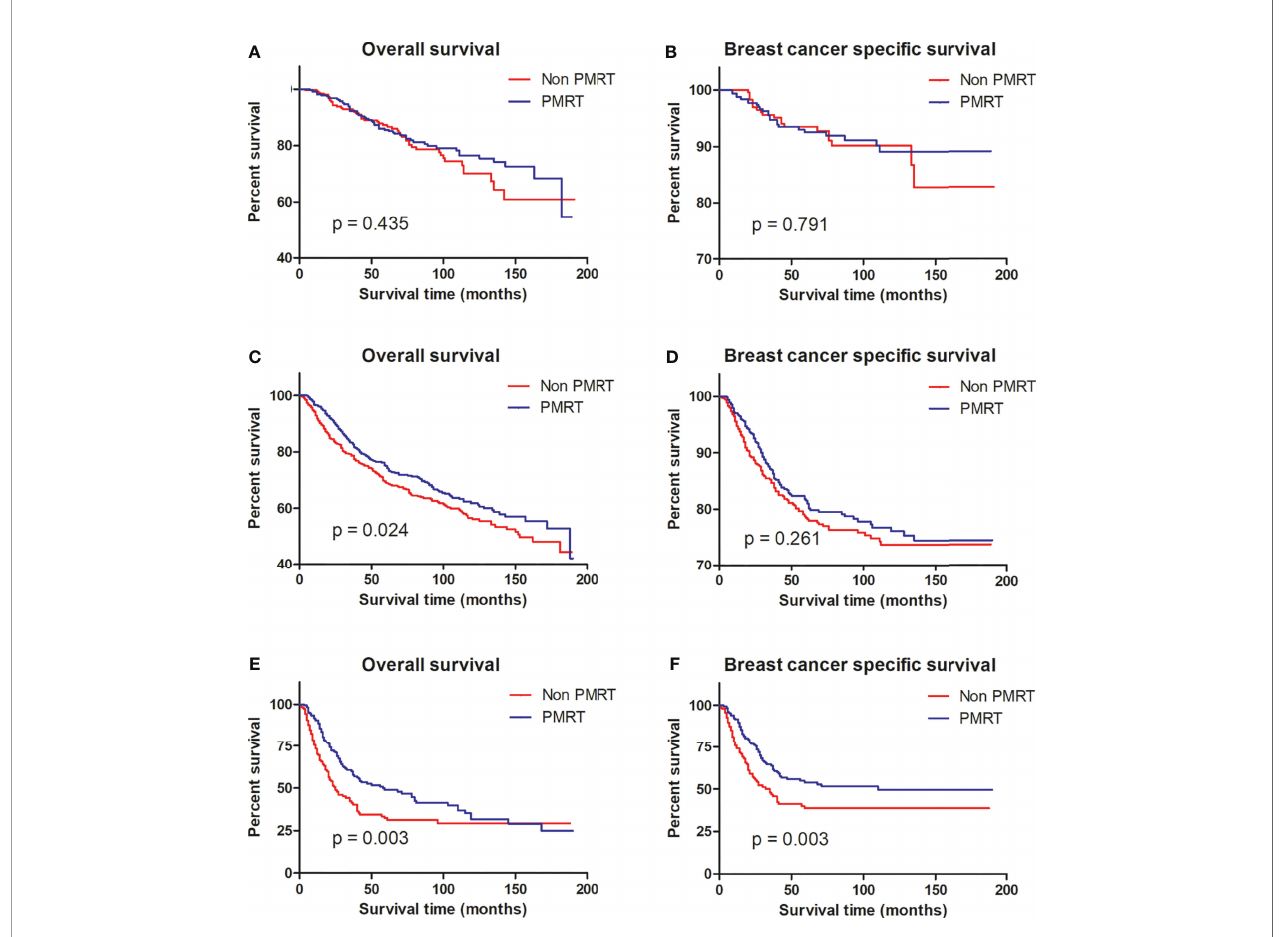
FIGURE 3 | OS and BCSS curves for all patients with MBC with and without PMRT in the low-risk (A, B) , intermediate-risk (C, D) , and high-risk (E, F) groups after PSM. MBC, metaplastic breast cancer; OS, overall survival; BCSS, breast cancer-special survival; PMRT, post mastectomy radiotherapy; PSM, propensity score